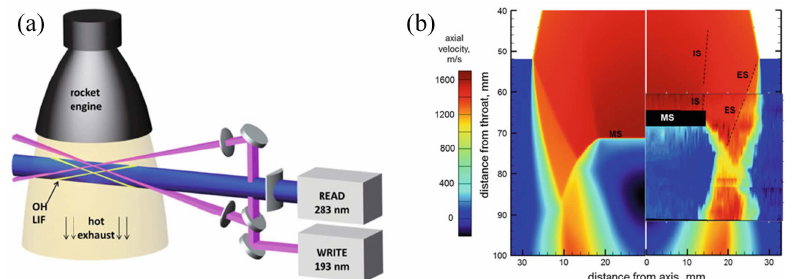
Figure 7. ( a ) Schematic of the measurement of rocket engine exhaust using the hydroxyl tagging velocimetry (HTV). ( b ) The corresponding measurement (inset) and simulation results